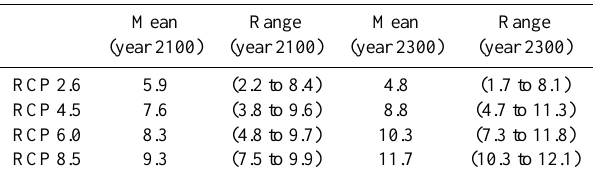
Table 3. Reduction in the size of the northern hemispheric per- mafrost region by year 2100 and 2300 relative to year 1850 (14.9millionkm 2 ). Ranges are 5th to 95th percentiles. All values are in million of km 2